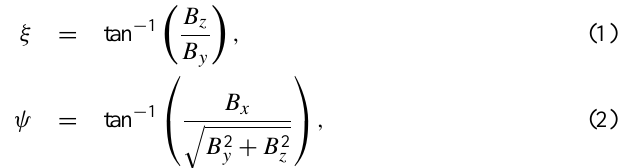
Fig. 5b and c for the magnetic field vectors in the X - Y